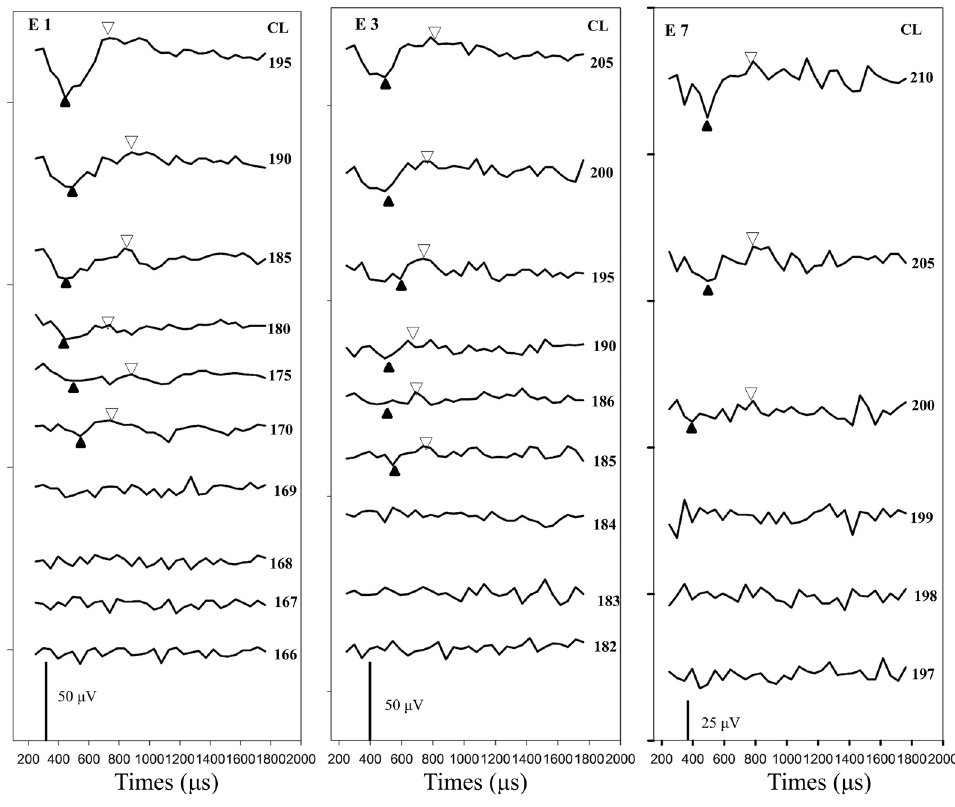
are labeled at the right side of the panel. The pulse width used in each electrode was 50 μs.